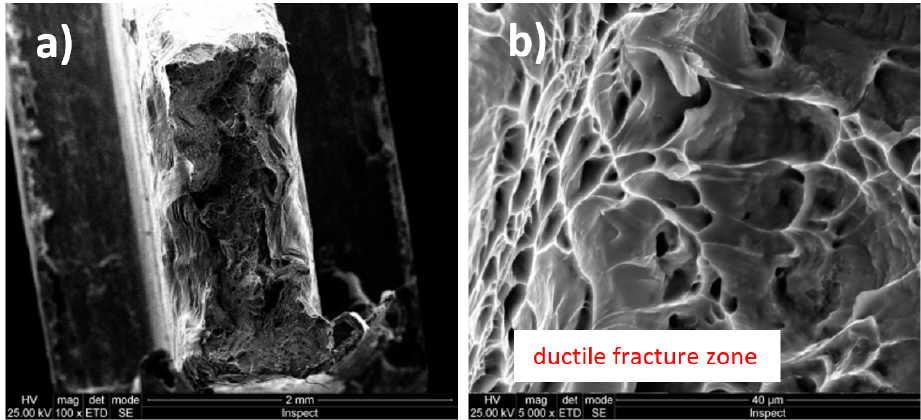
Figure 3. Fracture surfaces (fractography) images of Ti20Mo7Zr5Ta alloy: ( a ) 100×; ( b ) 5000×.